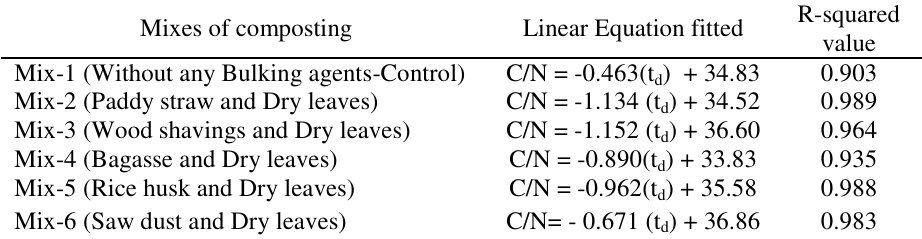
Table 2 . Linear equation fitted to reduction in C/N ratio with time duration for different mixes of